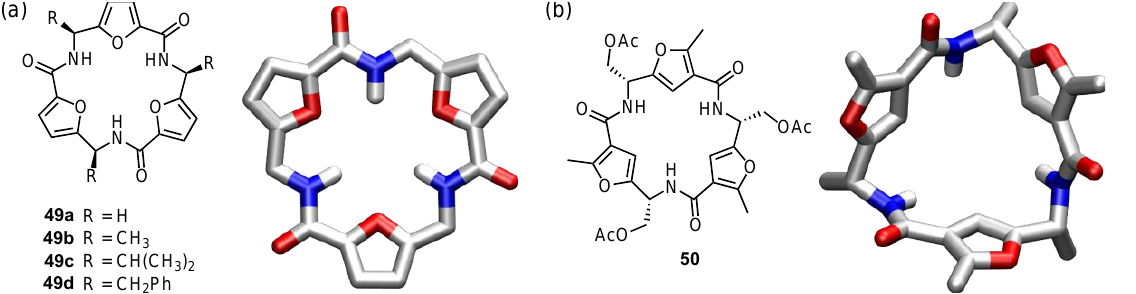
Figure 19. Structures and preferred calculated conformations of the furan-containing cyclopeptides 49a – d ( a ) and 50 ( b ). The structures of 49a and 50 were calculated by the author of this review based on the reported results by using Spartan 20 (Wavefunction, Inc., Irvine, CA, USA) and the MMFF force-field (see Supporting Information). The side chains of 50 are truncated and protons, except acidic ones, are omitted for reasons of clarity.